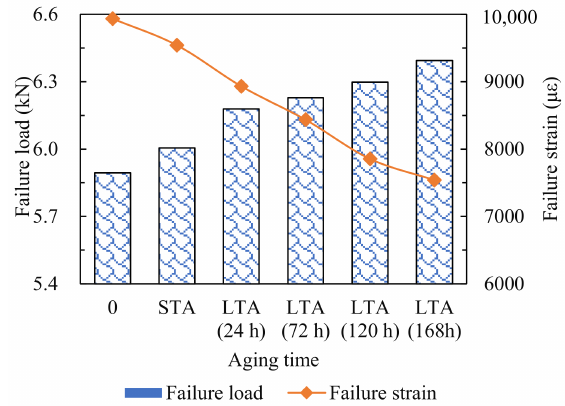
Figure 8. Failure loads and failure strains of